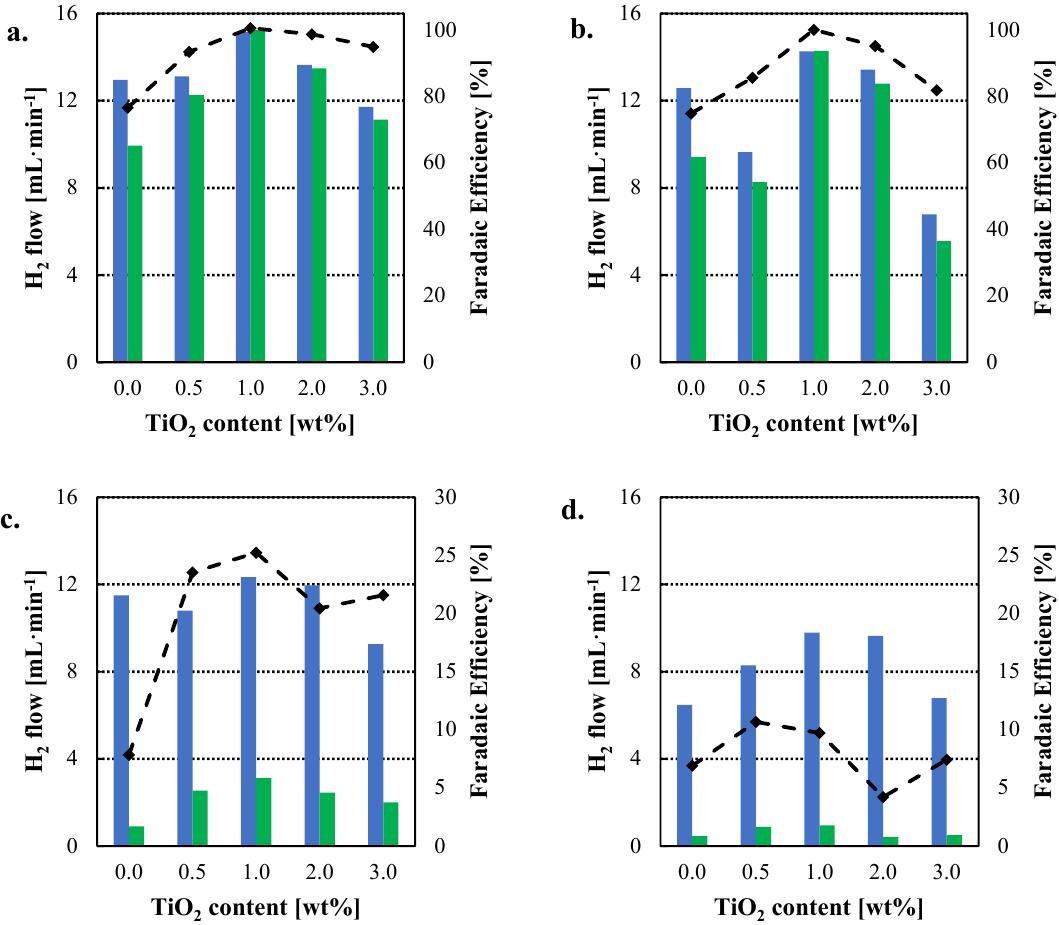
Figure 5. Hydrogen production rate for the pristine and composite membranes; ( a ). 110 ◦ C; ( b ). 120 ◦ C; ( c ).130 ◦ C; ( d ). 140 ◦ C. Blue columns: theoretical faradaic hydrogen rate; Green columns: experimental hydrogen production rates; Dashed line: Faradaic efficiency.